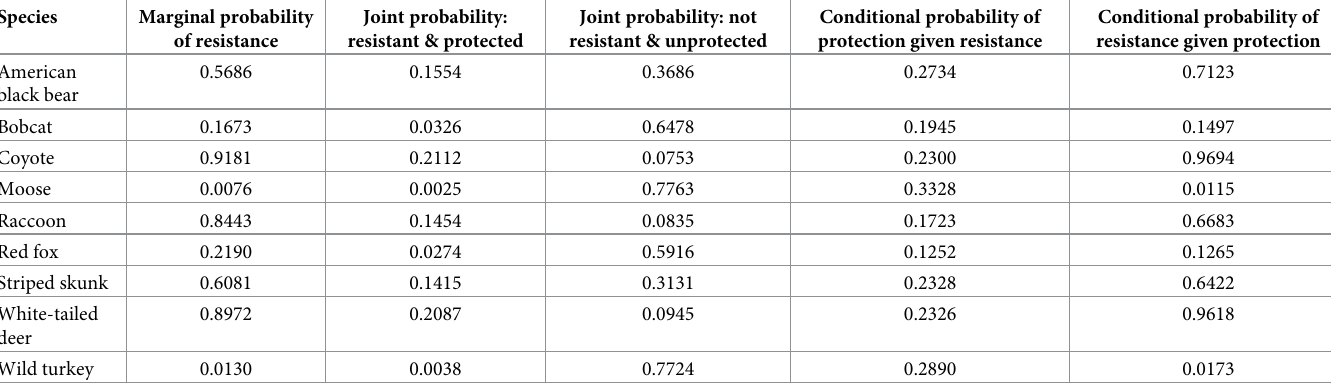
Table 5. Protected area resistance statistics for nine wildlife species in New England,